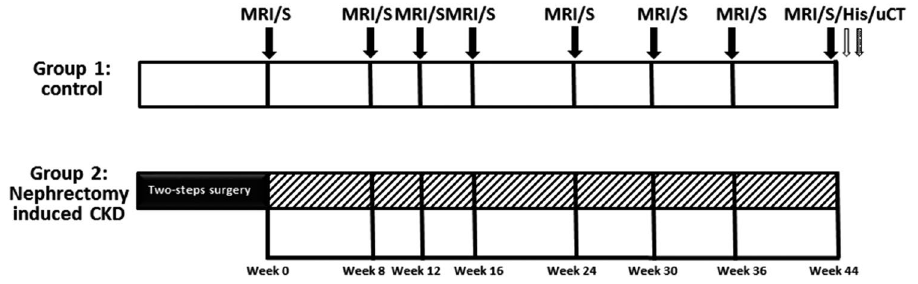
Figure 1. A schematic diagram of the experimental design. The chart shows the time points of MRI and MRS studies (indicated by ↓ ); histologic examination (indicated by ⇩ ), and μ CT examination (indicated by